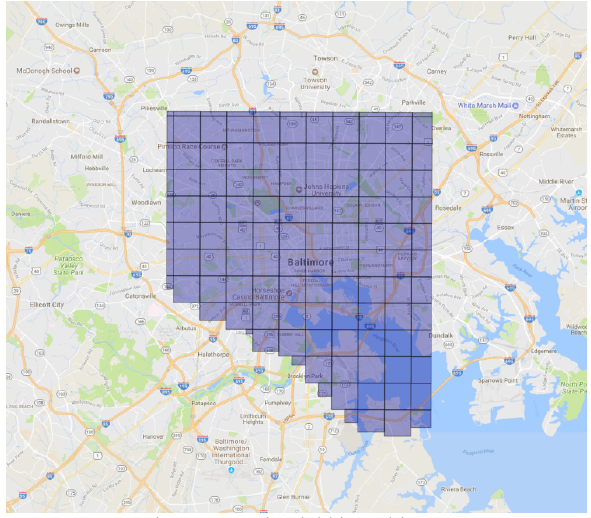
Figure 2. Study Field in